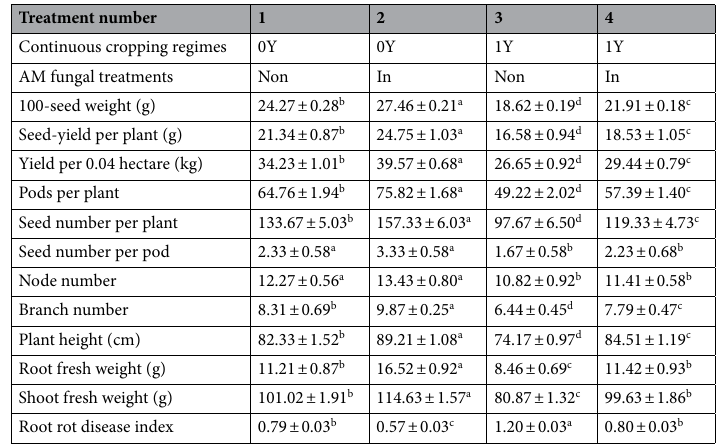
Table 2. Factorial design results of soybean growth/yield and disease index of soybean root rot. 0Y and 1Y represent 0 year and 1 year of continuous cropping, respectively. Non represents non-inoculated with R. intraradices . In represents inoculated with R. intraradices . Different letters indicate significant differences from different treatments ( P <